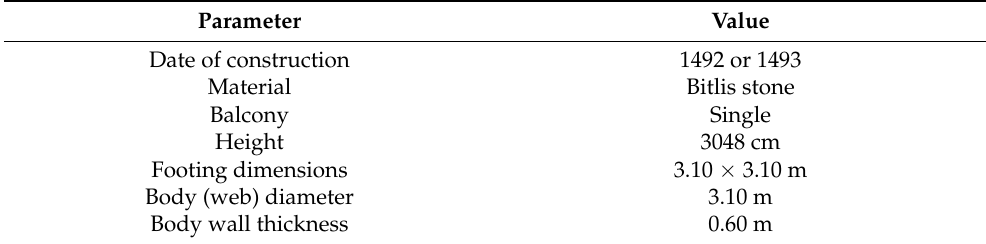
Table 1. Bitlis Grand Mosque and minaret